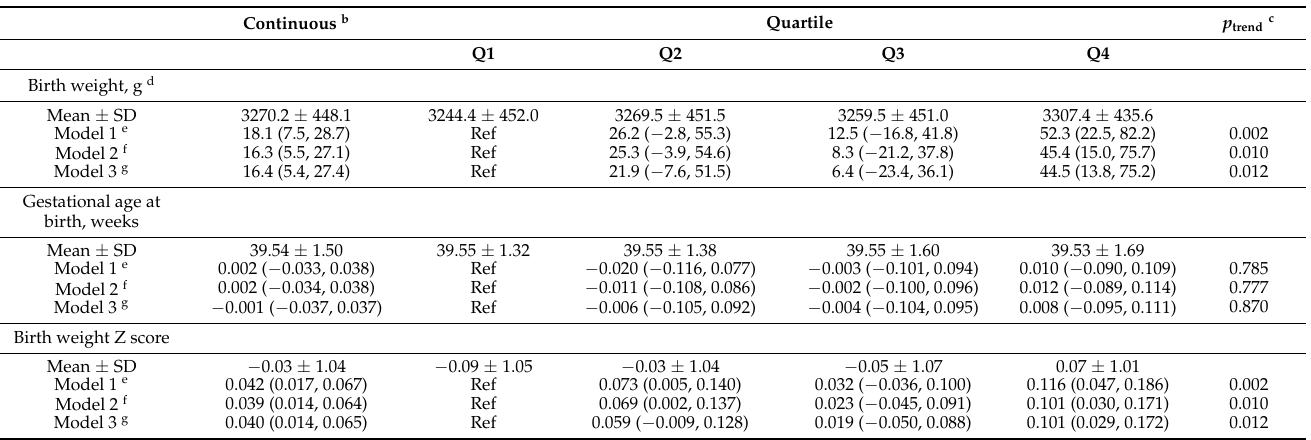
Table 3. Associations between the high B-vitamin dietary pattern score and continuous birth outcomes a .